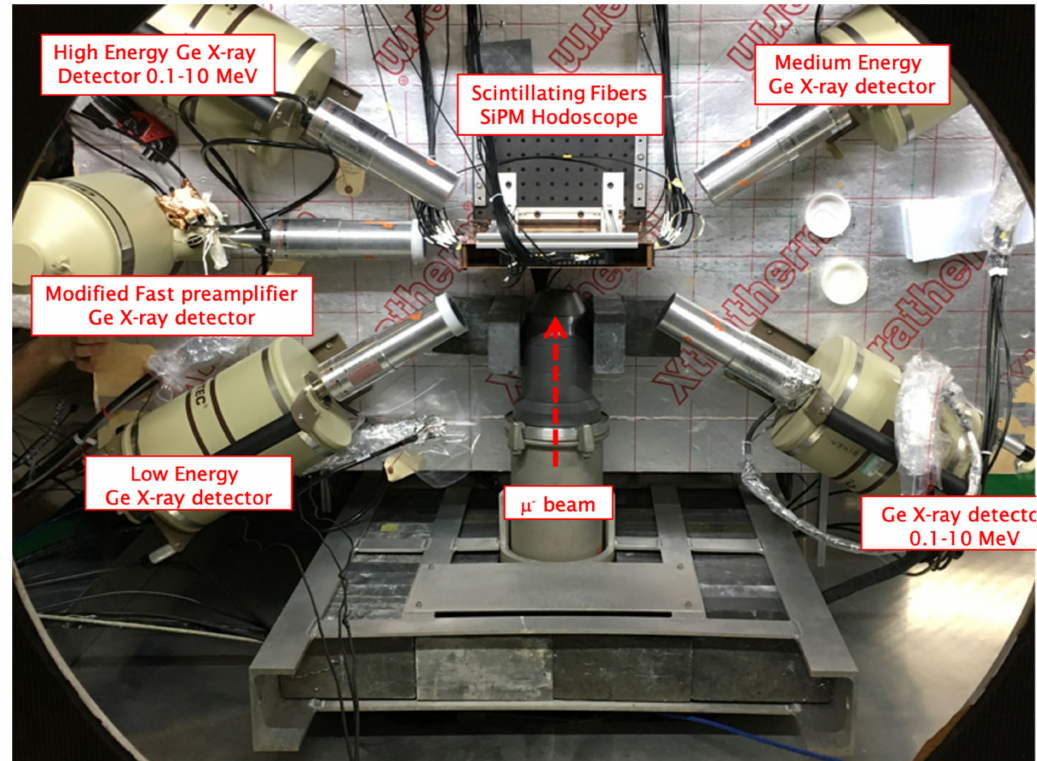
Figure 9. Experimental setup for MAXRS at RIKEN-RAL: 5 HpGe for low-, medium-, and high-energy X-ray detection and scintillating fibers hodoscope placed instead of the sample, for muon beam